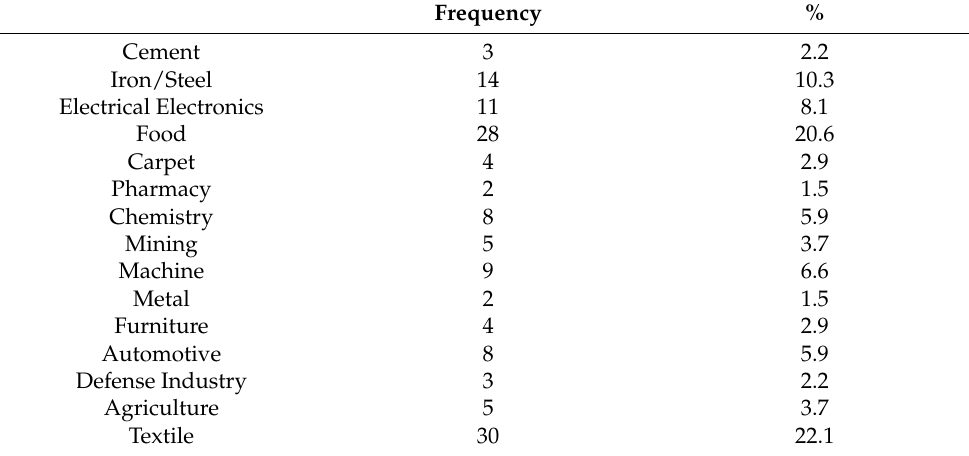
Table 1. Sectors of